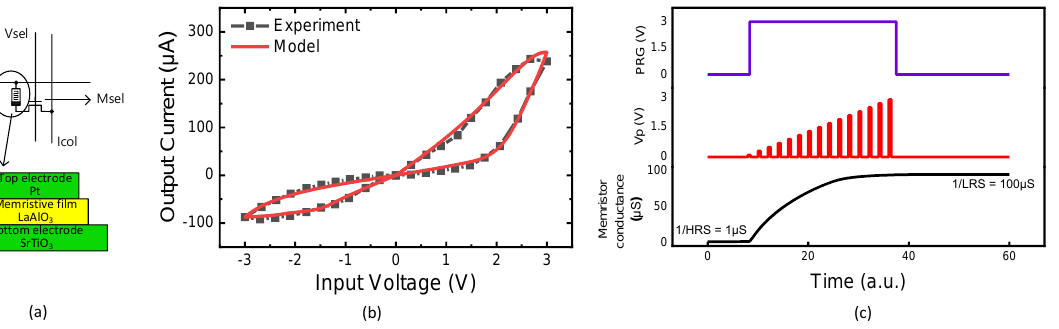
Figure 8. ( a ) The memristor circuit with a 1T(transistor)-1R(memristor) cell. The memristor is composed of a top electrode, memristive film, and bottom electrode. ( b ) The memristor’s butterfly curves from the experimental data (black box) and Verilog-A model (red line). ( c ) The simulated waveforms of memristor circuit [28].